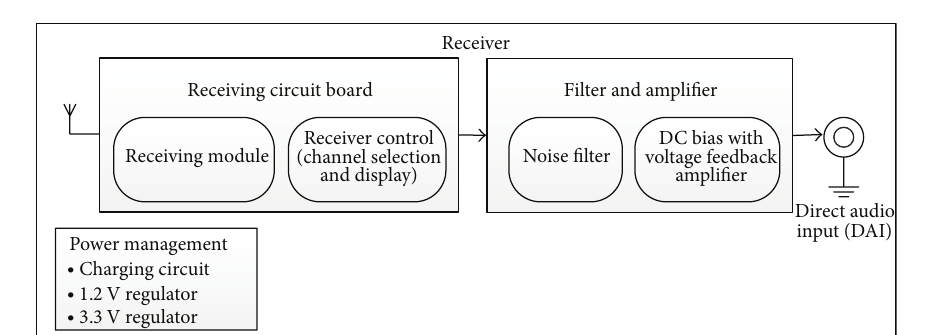
Figure 2: Transmitter module.